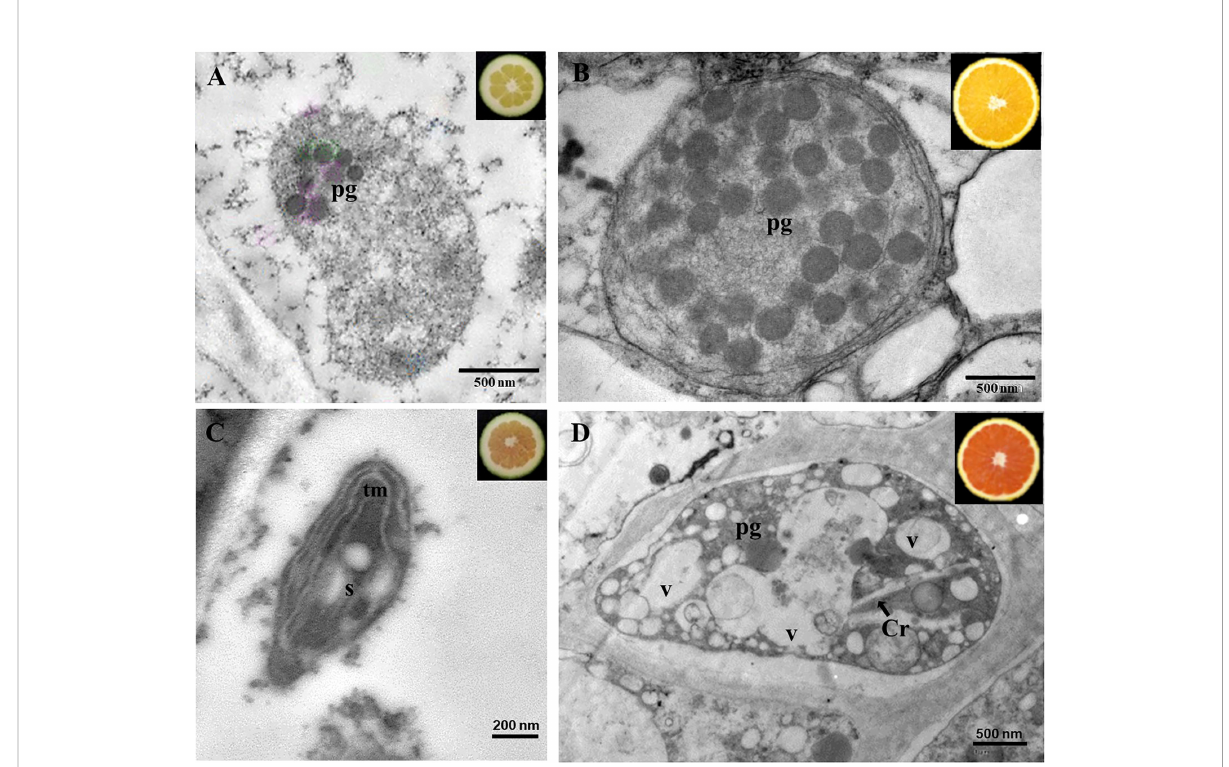
FIGURE 4 Transmission electron microscopy pictures of chromoplasts of the pulp of immature (A) and mature (B) fruits of Navel, and immature (C) and mature (D) fruits of Kirkwood. Pg, plastoglobuli; tm, tubular membranes; V; vesicles; S, starch; Cr, crystals of